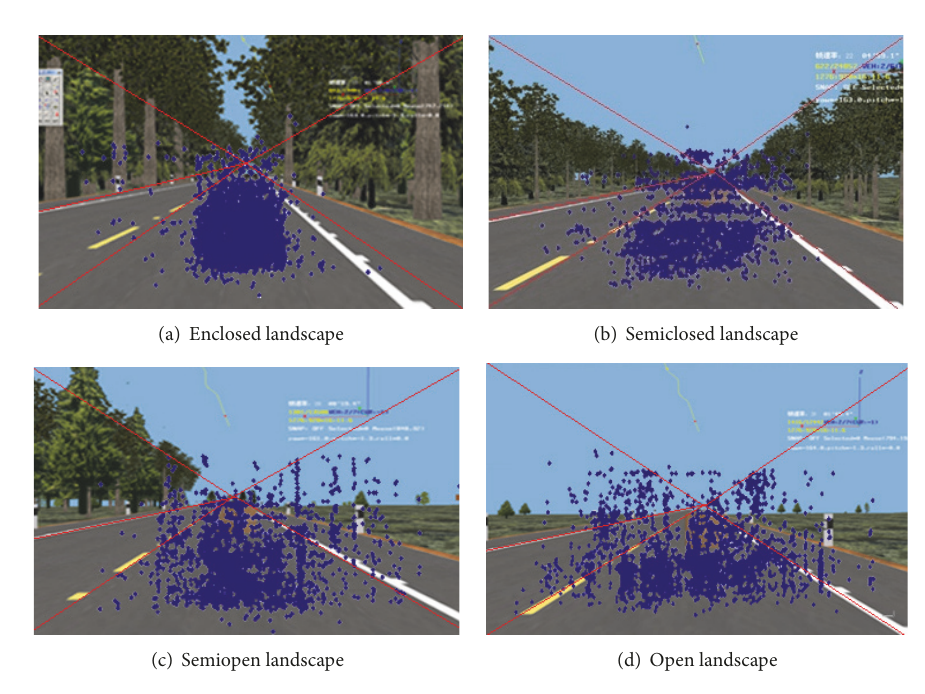
Figure 6: Drivers’ fixation scatter plots in different landscapes.